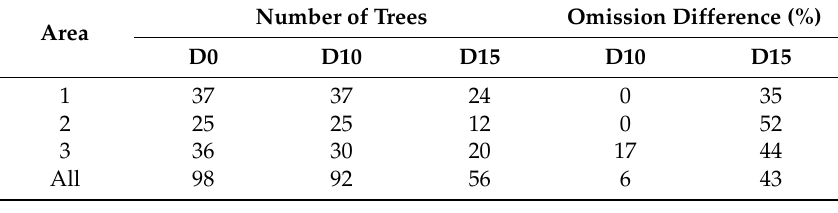
Table 3. Number of trees estimated with D10 and D15 scans vs the reference data (D0 scan). Area